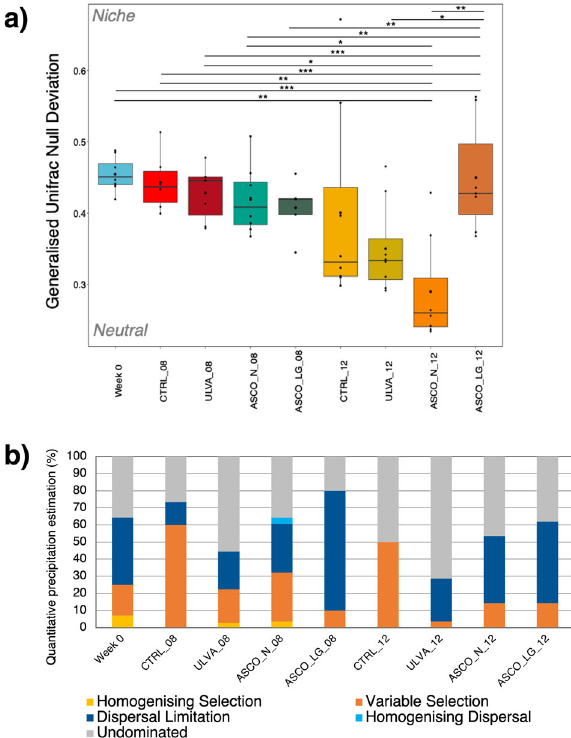
Fig. 3 Quanti fi cation of microbial community assembly in the gut microbiota of Atlantic cod. a The hindgut microbiota of juvenile Atlantic cod is increasingly shaped by neutral assembly processes over time irrespective of dietary treatment, except for the ASCO_LG samples. In the boxplots, center value lines indicate the median, boxes indicate the lower/upper quartiles (25%/75%) and lines extending parallel from the boxes (whiskers) show the variability outside the upper and lower quartiles. Lines connecting categories shows signi fi cant relationships (pairwise t-test) with *( p < 0.05), **( p < 0.01), or ***( p < 0.001). b The percentage contribution of assembly processes varies over time and across dietary treatments. Variable selection increased in the CTRL samples. Dispersal limitation increased in both ASCO treatments. In comparison, the ULVA treatment showed an increased contribution of undominated